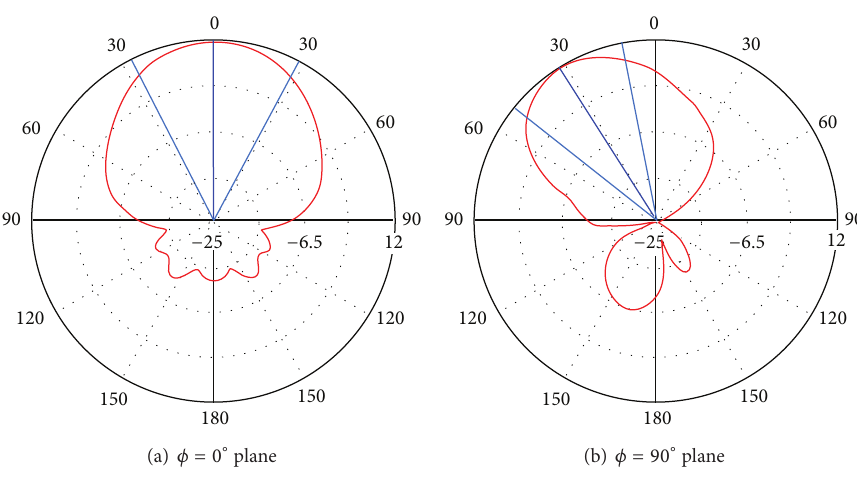
Figure 3: Gain patterns of step-cut design (using CST).